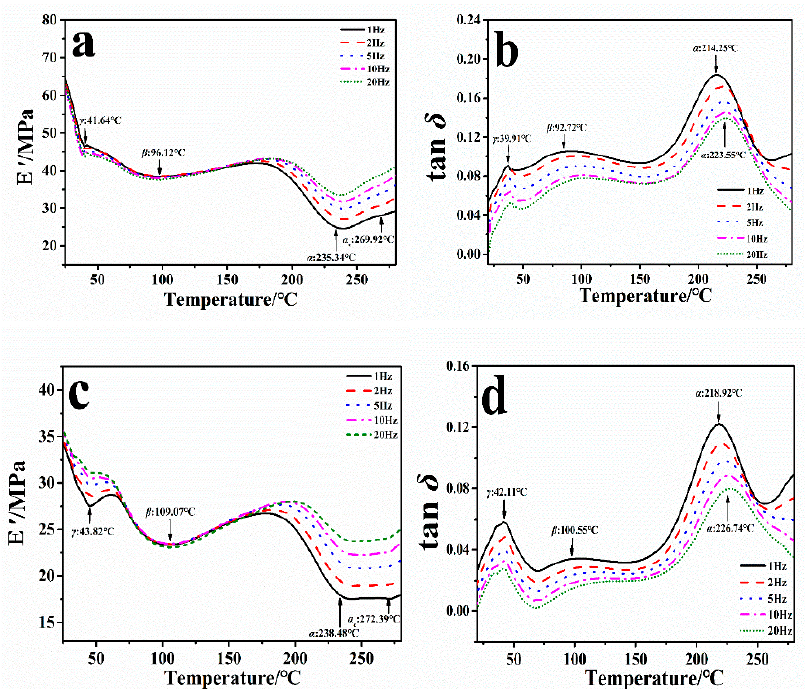
Figure 1. Dynamic mechanical analysis of the storage modulus ( E ′ ) curves of Chin silk fibroin fibers ( a ) and Thai silk fibroin fibers ( c ); and tan δ curves of Chin silk fibroin fibers ( b ) and Thai silk fibroin fibers ( d ) at five different frequencies: 1 Hz (solid line), 2 Hz (dash line), 5 Hz (dot line), 10 Hz (dash dot line), and 20 Hz (short dot line). Table 1. The water content of different SF film samples by Thermogravimetric Analysis (TG) *. Sample Water Content/% Sample Water Content/% CRS